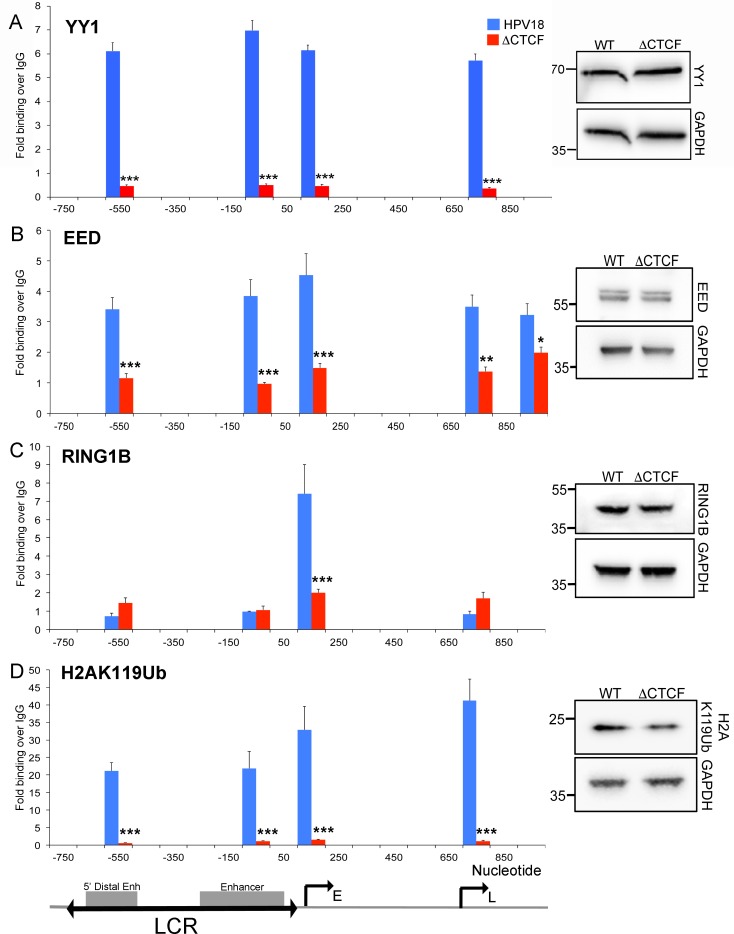
Abrogation of CTCF binding to the E2 ORF reduces YY1 and polycomb recruitment to the HPV18 episome.YY1 (A), EED (B), Ring1B (C), and H2AK119Ub (D) enrichment were assessed by ChIP-qPCR of amplicons within the HPV18 LCR. Data are represented as mean ± SD. (*p < 0.05, **p < 0.01, ***p < 0.001). Relative protein expression is shown in the western blots. The viral LCR, Enh regions, and early and late promoters are indicated. All raw quantitative data are enclosed in S1 Data. ChIP-qPCR, chromatin immunoprecipitation followed by quantitative PCR; CTCF, CCCTC-binding factor; E, early promoter; EED, embryonic ectoderm development; Enh, enhancer; GAPDH, Glyceraldehyde-3-phosphate dehydrogenase; H2AK119Ub, histone 2A lysine 119 ubiquitinylation; HPV, human papillomavirus; L, late promoter; LCR, long control region; ORF, open reading frame; Ring1B, ring finger protein 1B; WT, wild-type; YY1, Yin Yang 1.